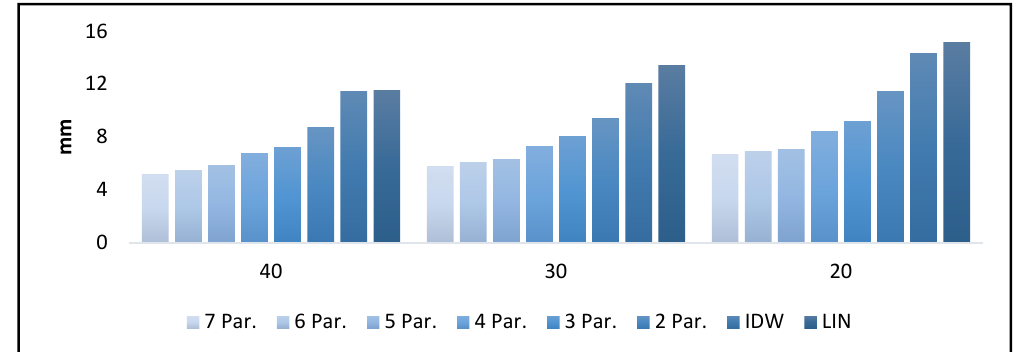
Figure 4. Root mean square error (RMSE) values of ANN models and linear interpolation method (LIN) and inverse distance weighted interpolation (IDW) methods.